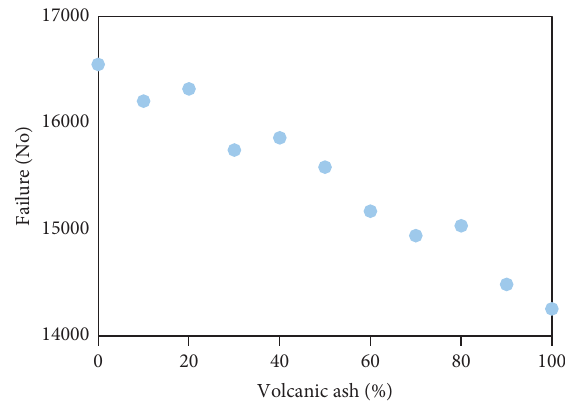
Figure 11: Impact of volcanic ash on the failure of the mix under repetition of